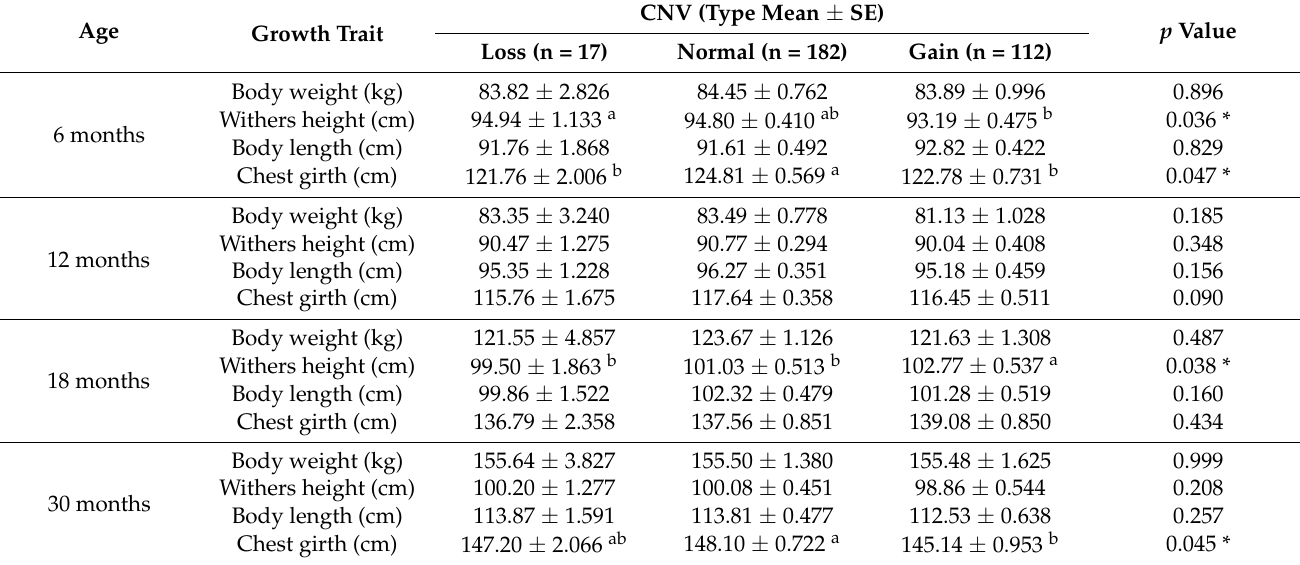
Table 3. ANOVA of the correlation between SOX6 -CNV and four growth traits in 311 Ashidan